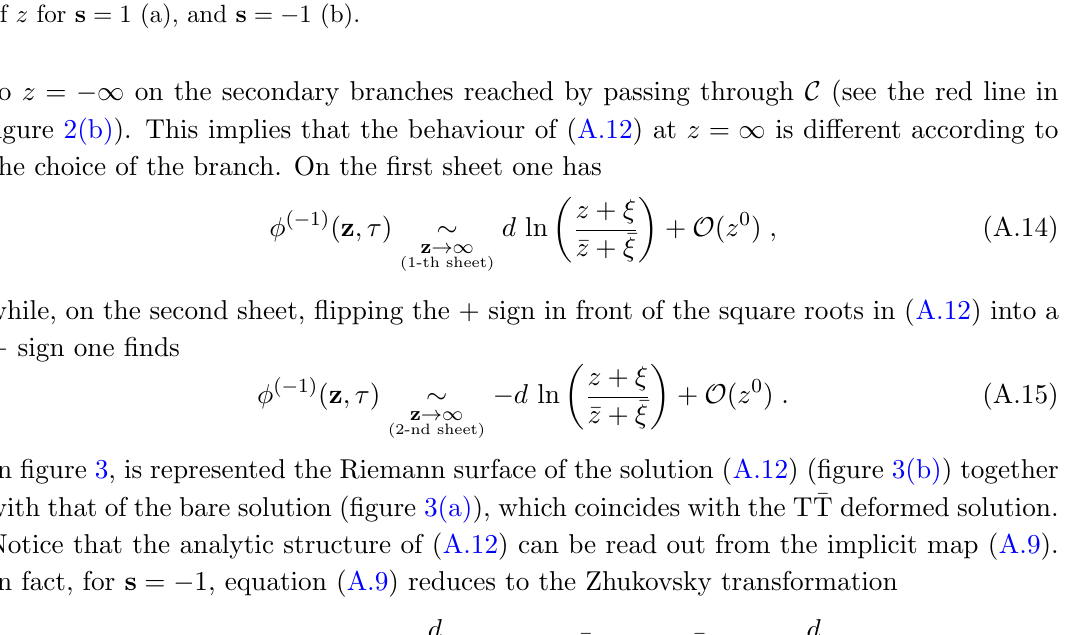
Figure 3 . Riemann surface of the deformed solution (cid:30) ( s ) ( z ; (cid:28) ) , ( (cid:24) = (cid:22) (cid:24) = 0), in the complex plane of z for s = 1 (a), and s = (cid:0) 1